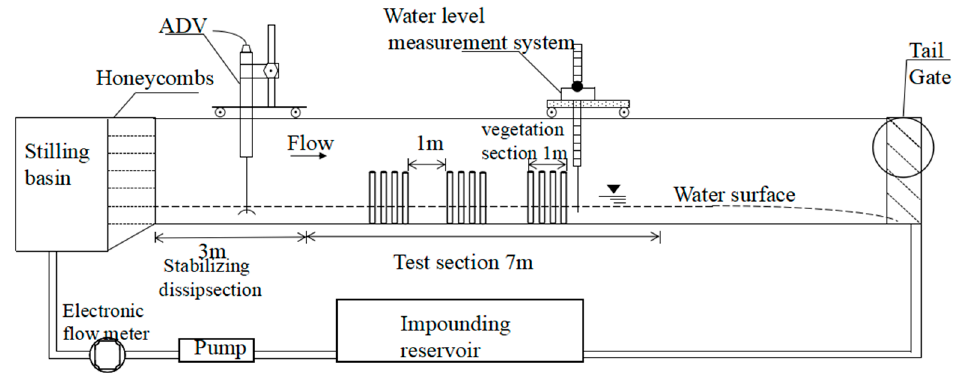
Figure 1. Schematic of the experimental setup (side view).